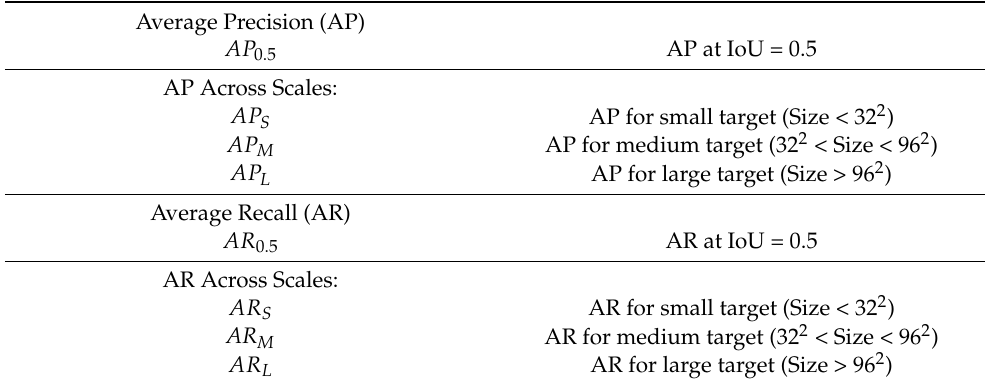
Table 4. Microsoft COCO standard—commonly used in object recognition tasks to evaluate the precision and recall of a model at multiple scales. The unit of AP and AR is